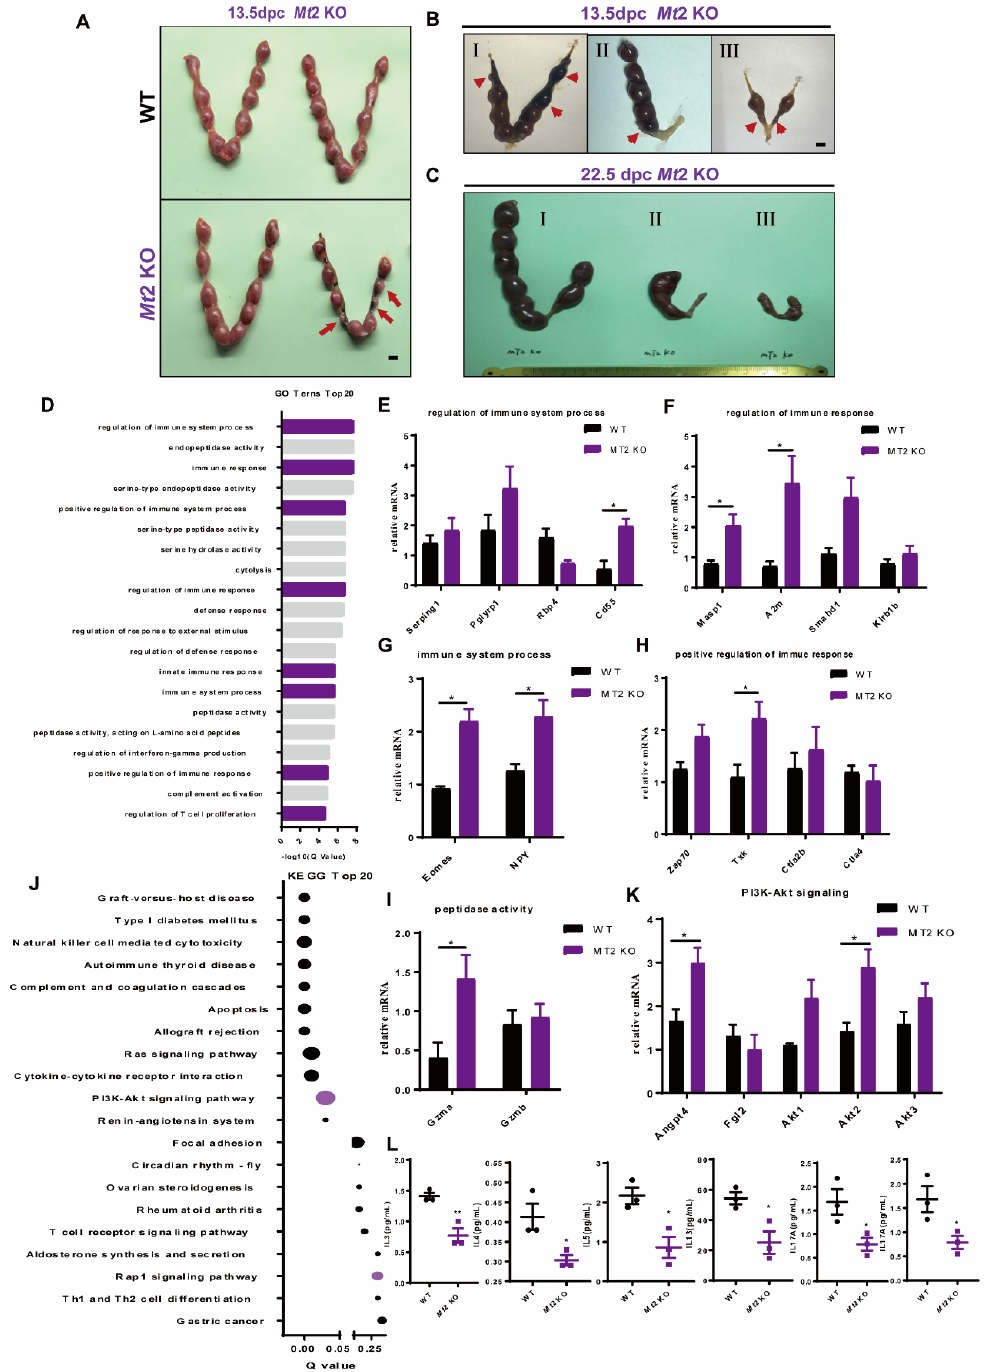
Figure 5. Effects of Mt2 KO on embryo loss and abnormal uterine immune function at 13.5 dpc in mice. ( A – C ) Uterine morphology. The red arrows indicate atrophy of implantation sites. I–III shows different degrees of morphological abnormalities. ( D ) GO enrichment analysis. ( E – I ) QPCR validation of GO term-related genes in uteri of 13.5 dpc (n = 3). ( J ) KEGG enrichment analysis. ( K ) QPCR validation of KEGG term-related genes in uteri of 13.5 dpc (n = 3). ( L ) Cytokines in uteri of 13.5 dpc (n = 3). Note: * p < 0.05, ** p < 0.01.